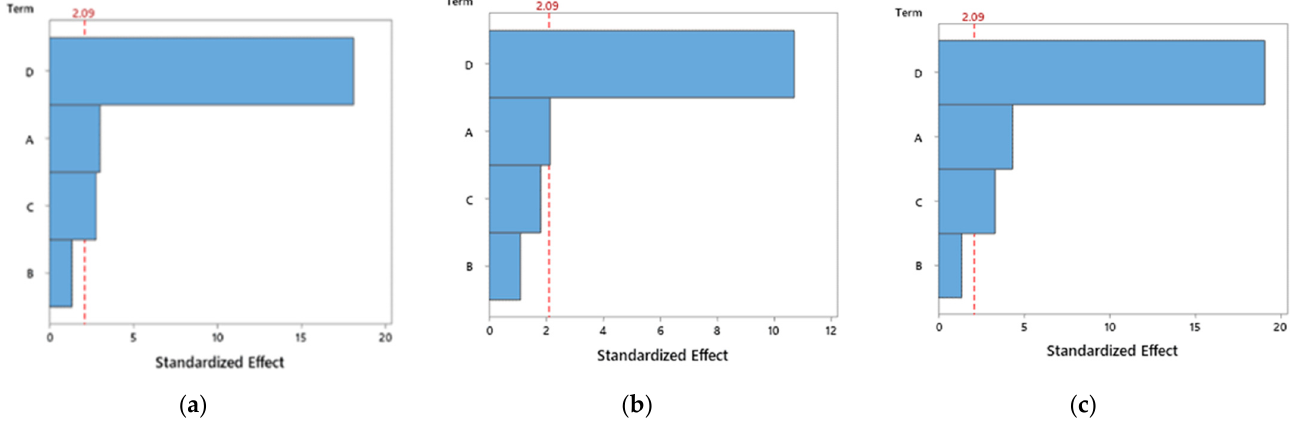
Figure 6. Pareto diagram for PETG and for: ( a ) bending stress; ( b ) bending modulus; ( c ) bending strain.